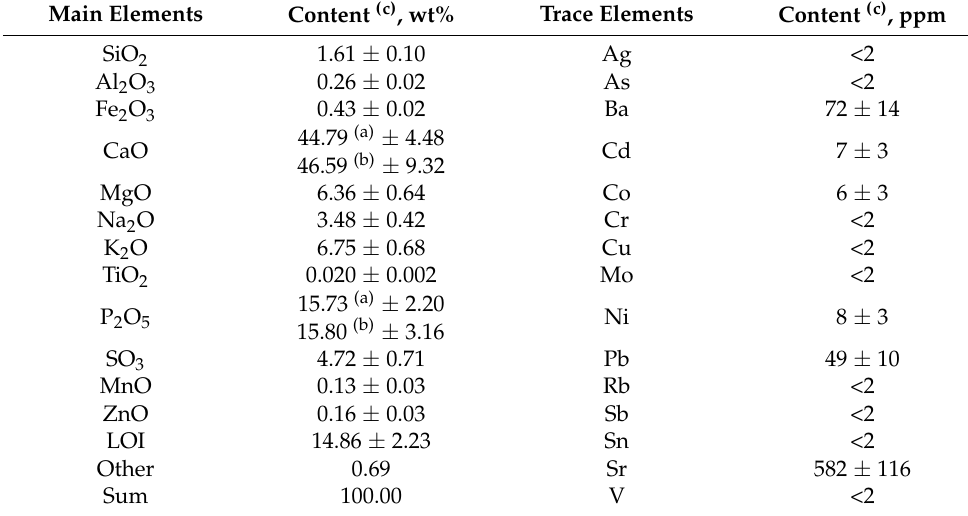
Table 4. Chemical composition of ash from poultry manure incineration (sample PMA).